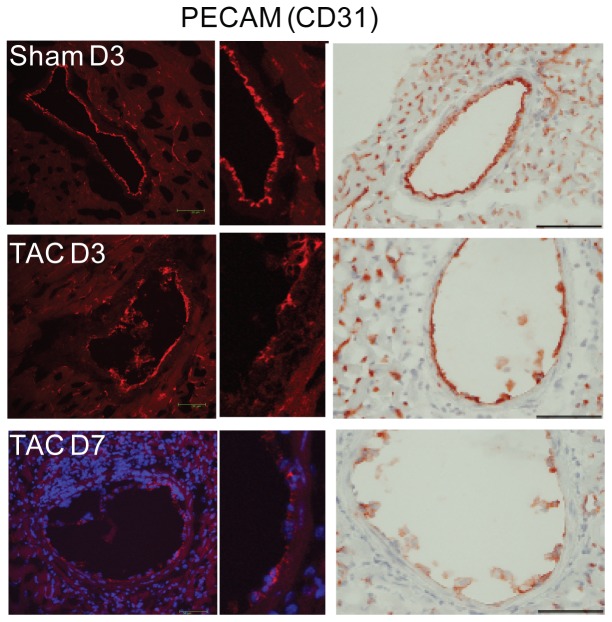
Endothelial disruption at three and seven days after TAC surgery.Confocal (left and middle panel) and IHC (right panel) images of PECAM (CD31) staining along the lumen of left coronary arteries at three days after sham surgery (sham D3) and at three (TAC D3) and seven days (TAC 7D) after TAC surgery. CD31 staining appears continuous along the luminal side in sham mice and discontinuous along similar vessels in TAC mice. Bar = 70 µm.